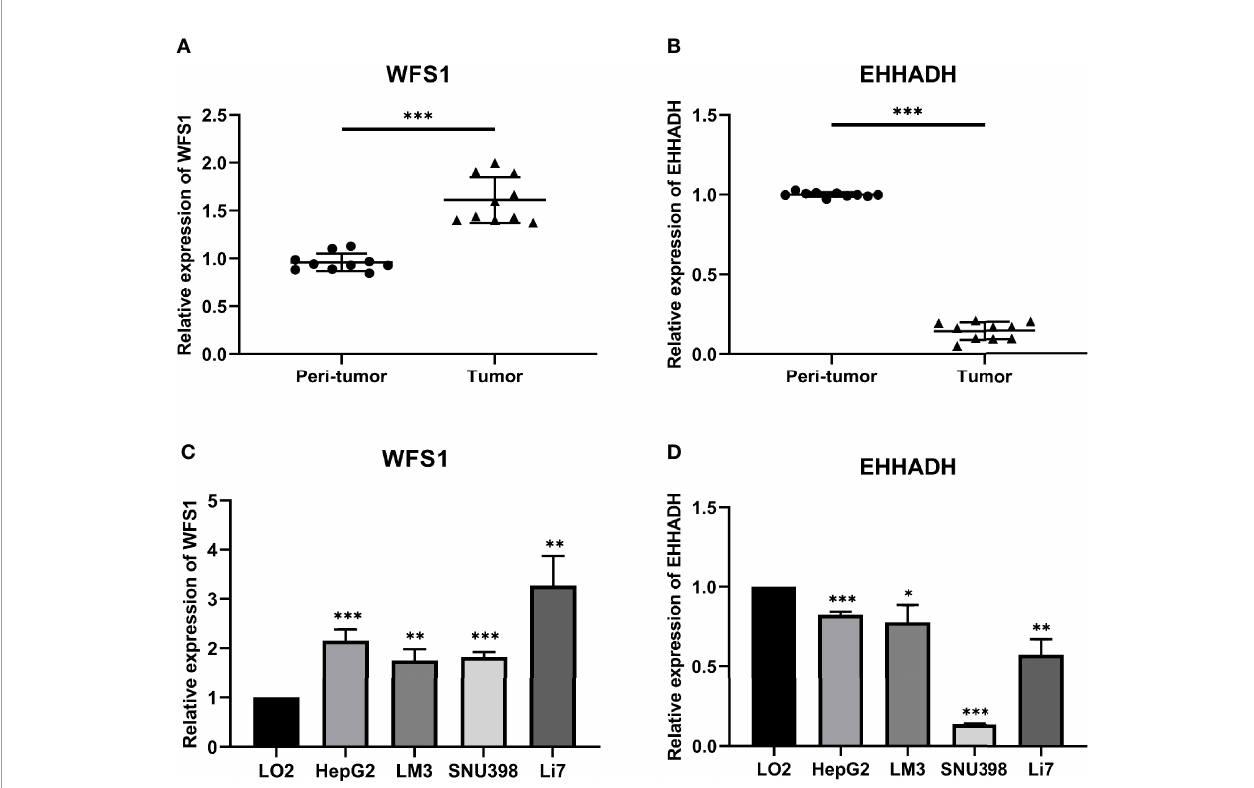
FIGURE 11 | Relative expression levels of WFS1 and EHHADH detected by qRT-PCR. (A) Scatter plots of WFS1 were constructed using qRT-PCR data of our own patients ’ cohort. (B) Scatter plots of EHHADH were constructed using qRT-PCR data of our own patients ’ cohort. (C) The expression levels of WFS1 in LO2 and 4 HCC cell lines (HepG2, LM3, SNU-398, and Li7) detected by qRT-PCR. (D) The expression levels of EHHADH in LO2 and 4 HCC cell lines (HepG2, LM3, SNU-398, and Li7) detected by qRT-PCR. *P < 0.05; **P < 0.01; ***P <